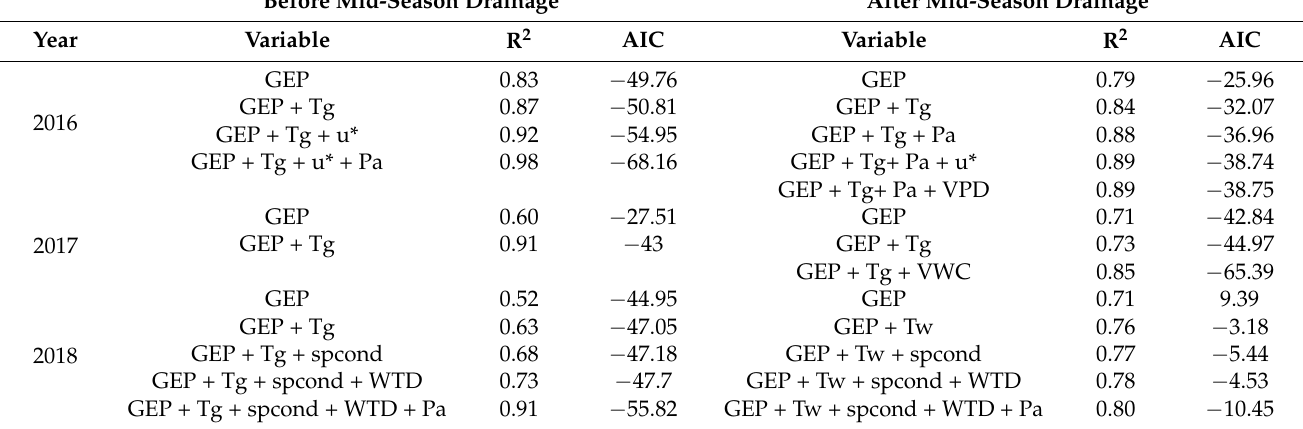
Table 3. Statistical tests (Coefficient of Determination (R 2 ) and Akaike Information Criterion (AIC)) for the biophysical drivers in the models of daily CH 4 fluxes in 2016–2018, including stepwise multivariate linear and hierarchical Neural Network Models. Daily CH 4 fluxes were log transformed before being fit with linear models. The results were only presented when the addition of the variable improved the R 2 of the model and was justified by a reduction in the AIC of the model. F CH4 is the daily CH 4 flux, Tg, Tw, GEP, VWC, u*, Pa, and spcond are abbreviated soil temperature, water temperature, gross ecosystem photosynthesis, volumetric water content, friction velocity, ambient pressure, and conductivity,